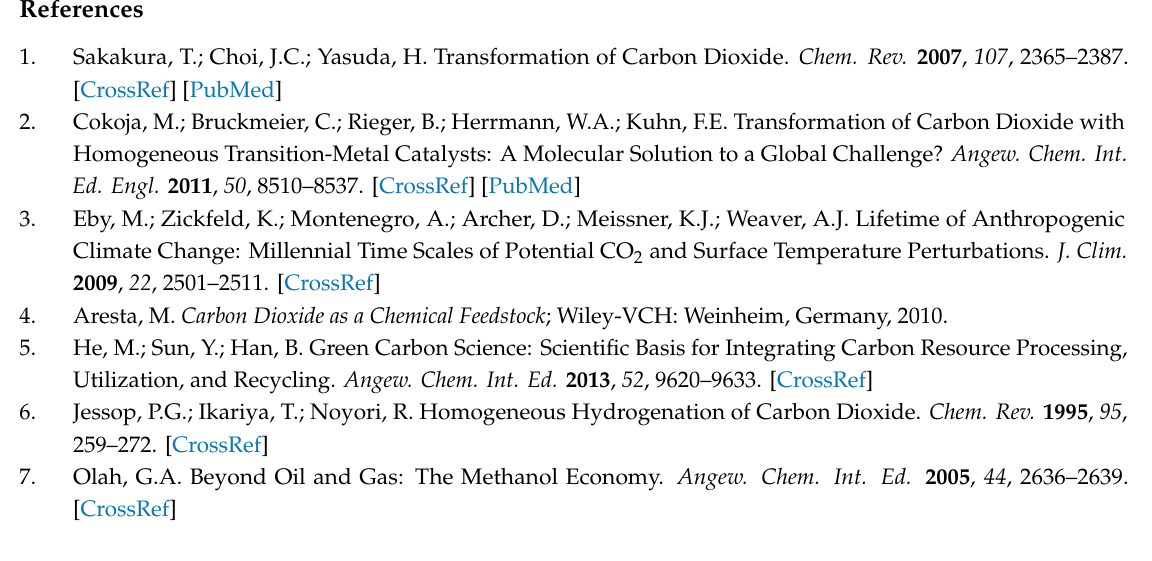
Table S1: Absolute and relative free energies of rate-determining states 4 and TS 1,2 calculated by using di ff erent density functionals, Table S2: Absolute and relative electronic energies of singlet and triplet